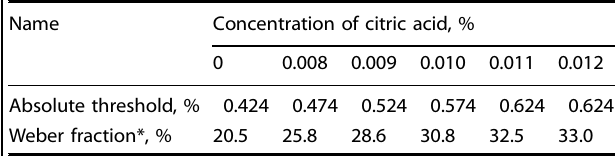
*The weber fraction is the ratio of difference threshold and original stimulus